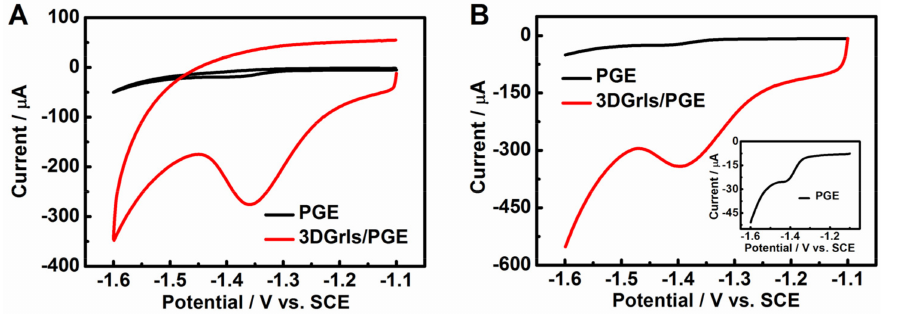
Figure 4. ( A ) CV and ( B ) LSV curves of PGE and 3DGrls/PGE in pH 9.18 PBS with 20- µ M HMF. The inset is the LSV at PGE. Scan rate: 50 mV s − 1